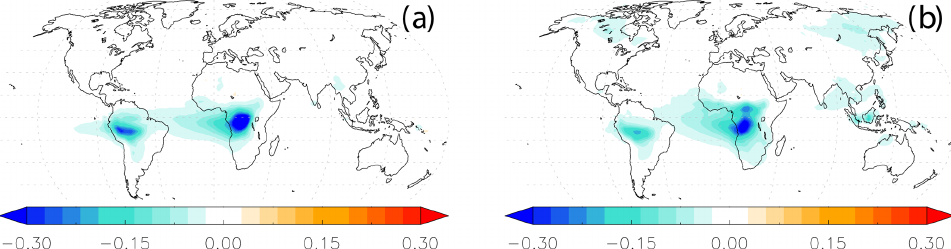
Figure 12. The difference in annual modeled clear-sky aerosol optical depth (AOD) between a simulation with no fire emissions to a simulation using pyrE fire emissions (a) and a simulation with offline GFED4s emissions (b) . The difference (model with no fire emissions – model with fire emissions) is based on an ensemble of 10